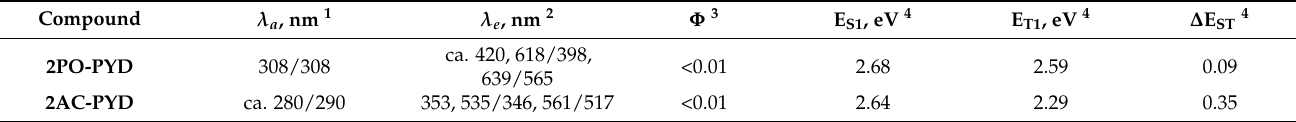
Table 2. Photophysical characteristics of 2PO-PYD and 2AC-PYD